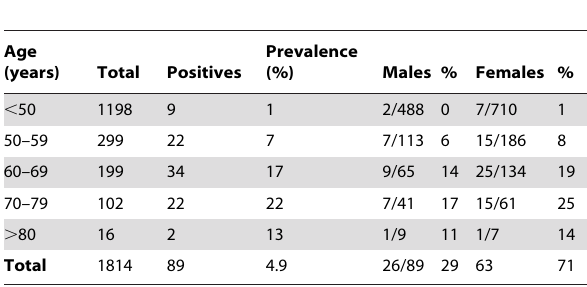
Table 2. Anti-HCV EIA prevalence by age in a total of 1814 volunteer sorted by age and